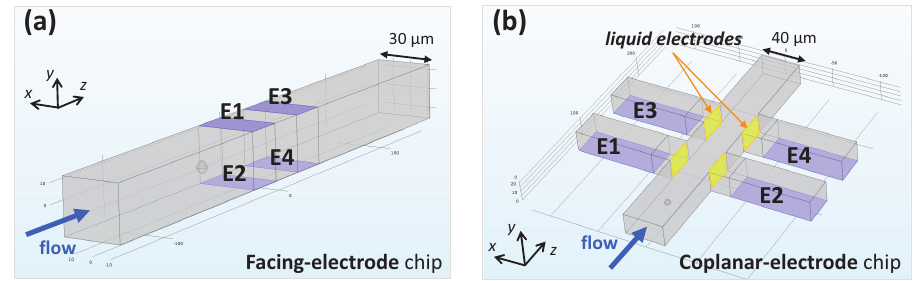
Figure 1. ( a ) Geometric model of a typical microfluidic impedance chip comprising two pairs of facing electrodes (E1–E2 and E3–E4 pairs). Dimensions are those of a commercial impedance chip by ( b ) Geometric model of an impedance chip with coplanar electrode configuration: two pairs of liquid electrodes [22,23] are generated by two pairs of metal electrodes (E1–E2 and E3–E4 pairs). Dimensions are: 40 µ m × 21.5 µ m cross-section ( W × H in xy -plane), 30 µ m lateral channels width and spacing ( || z ), 20 µ m electrode recess with respect to the main channel ( || x